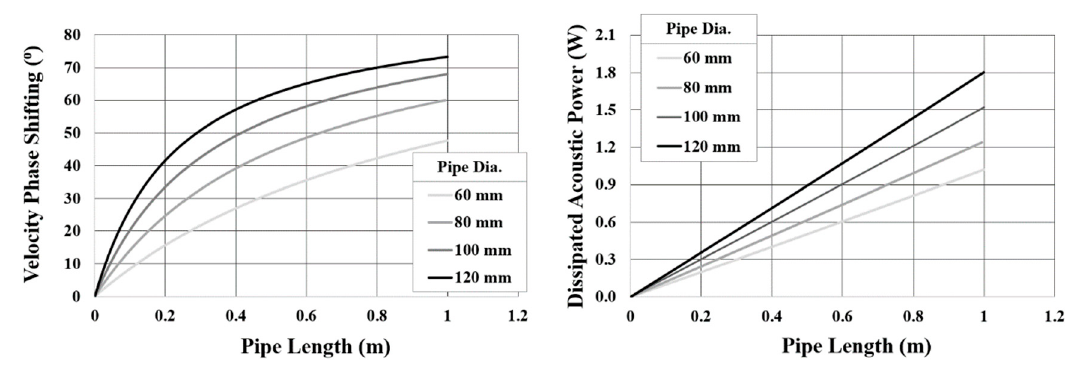
Figure 15. Effect of pipe length and diameter of the inertance pipe on ( a ) pressure phase shifting; ( b ) dissipated acoustic power.